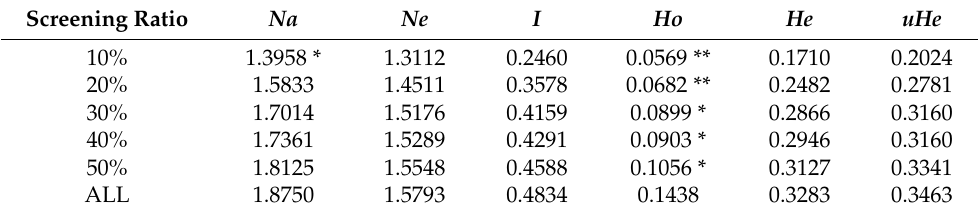
Table 3. Genetic diversity parameters of all germplasms and core